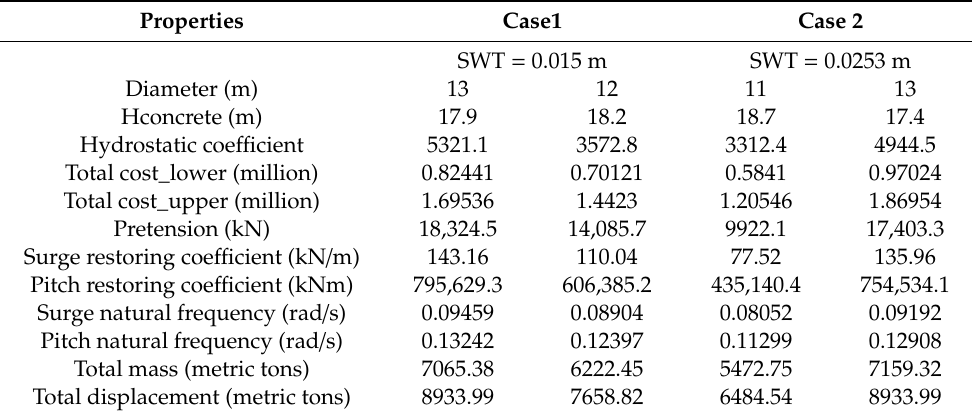
Figure 7. Surge and pitch restoring stiffness for three cases with SWT = ( a ) 0.015 m, ( b ) 0.0253 m, ( c ) 0.045 m. The solid black line is the lower limit for C 11 , while the black dash line represents the lower limit for C 55 . Table 7. Properties of the optimized design after Step 2.